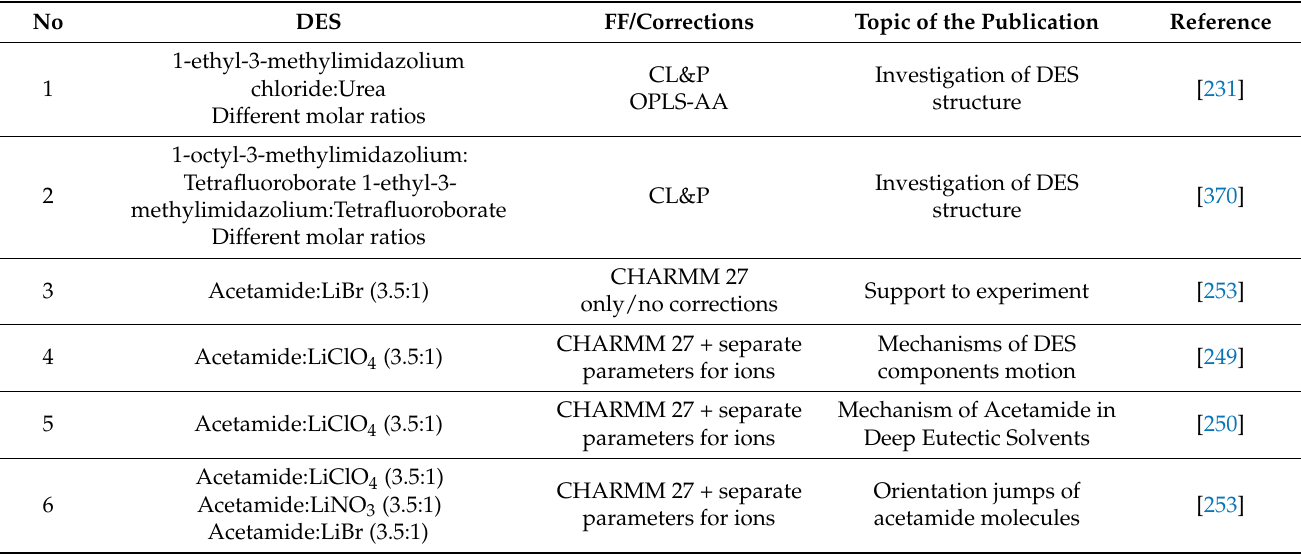
Table A1. Atomistic simulations of DES consisting systems, force field used, and the topic of